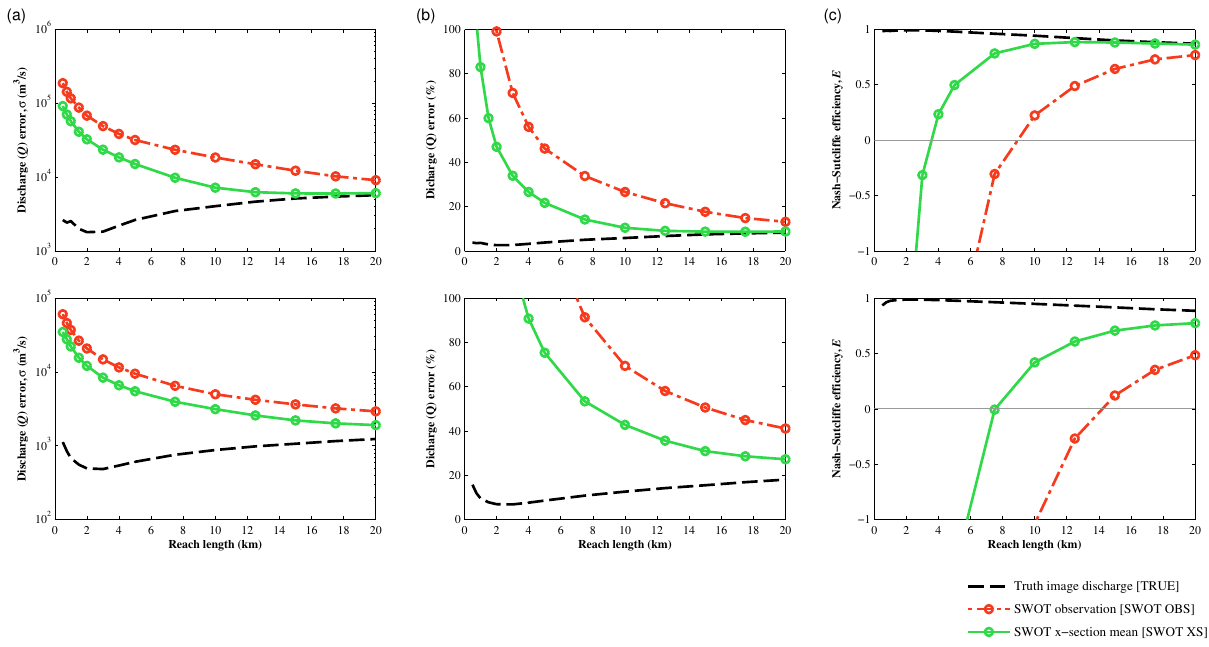
Figure 14. Errors in discharge ( Q ) calculated against model discharge ( Q [ MODEL ] ): (a) absolute discharge error; (b) error expressed as a percentage of mean discharge; and (c) Nash–Sutcliffe efficiency coefficient. Top row: Solimões; bottom row: